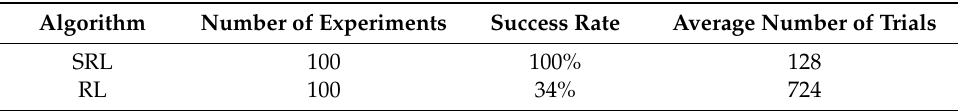
Table 1. Training results of SRL and